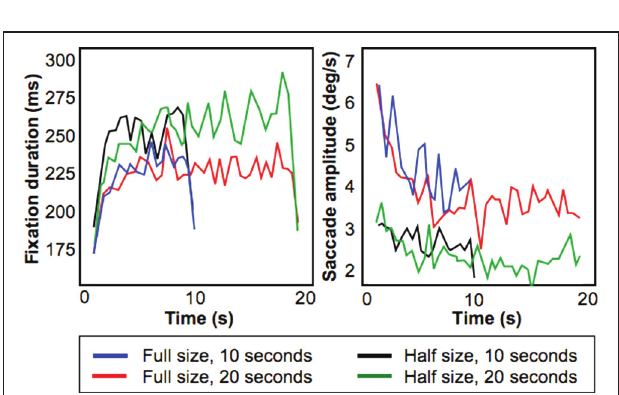
inspection). Count is the total number of events for all subjects. Panel D shows fixation duration over stimulus presentation time with a running average across 50 ms. Panel E shows the saccade amplitude over stimulus presentation time with a running average across 50 ms.